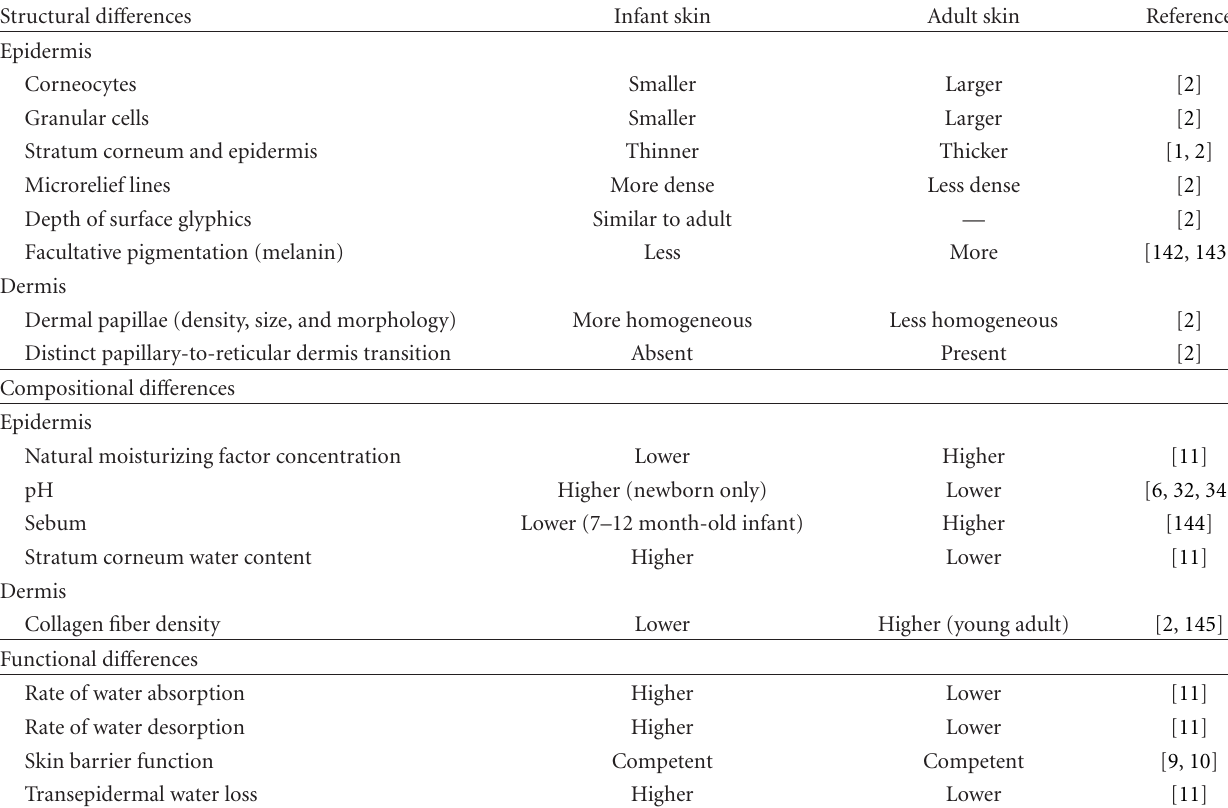
Table 1: Infant and adult skin: similarities and di ff erences.